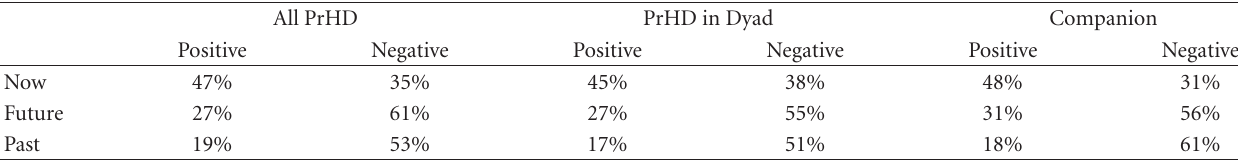
Table 4: Valence of QOL statements by time frame.